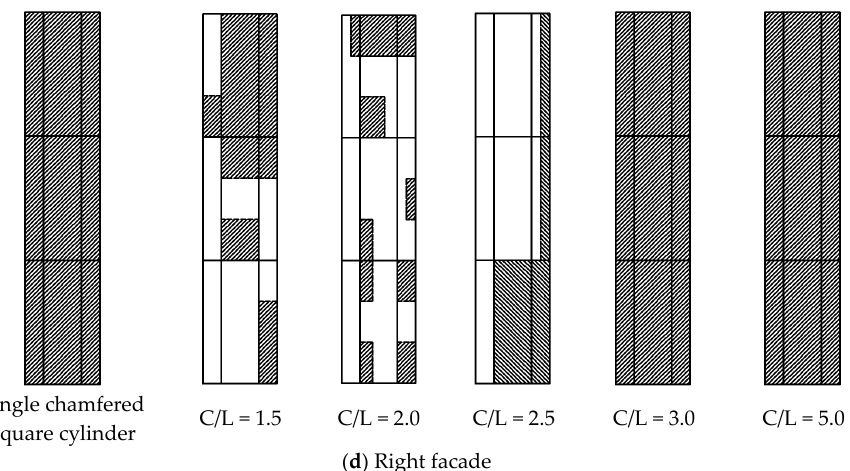
Figure 10. Non-Gaussian wind pressure distribution area of tandem square cylinder (filled region).